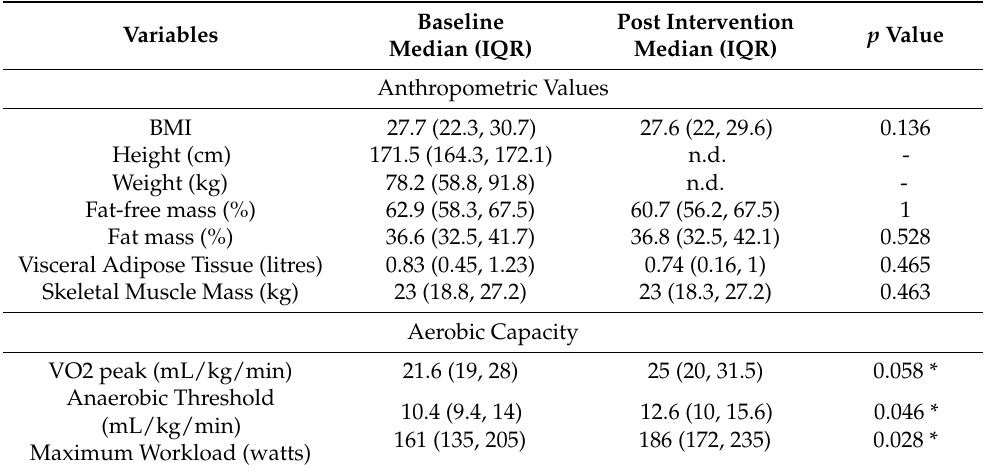
Table 2. Body composition and aerobic